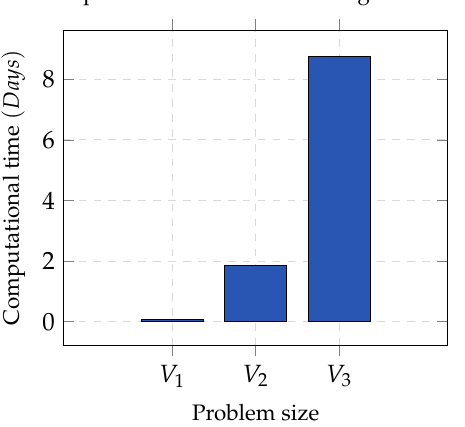
Figure 1. Analysis of the computational time while matrix size increased. Three constructed in silico datasets were proposed, represented by large matrices ( V 1 ∈ R 1794,27 , V 2 ∈ R 15000,193 , and V 3 ∈ R 10180,856 ). For the three experiments, it was fixed (cid:101) = 10 − 12 and k ∈ [ 2,10 ] . We executed the algorithm 32 times in order to obtain a statistically significant